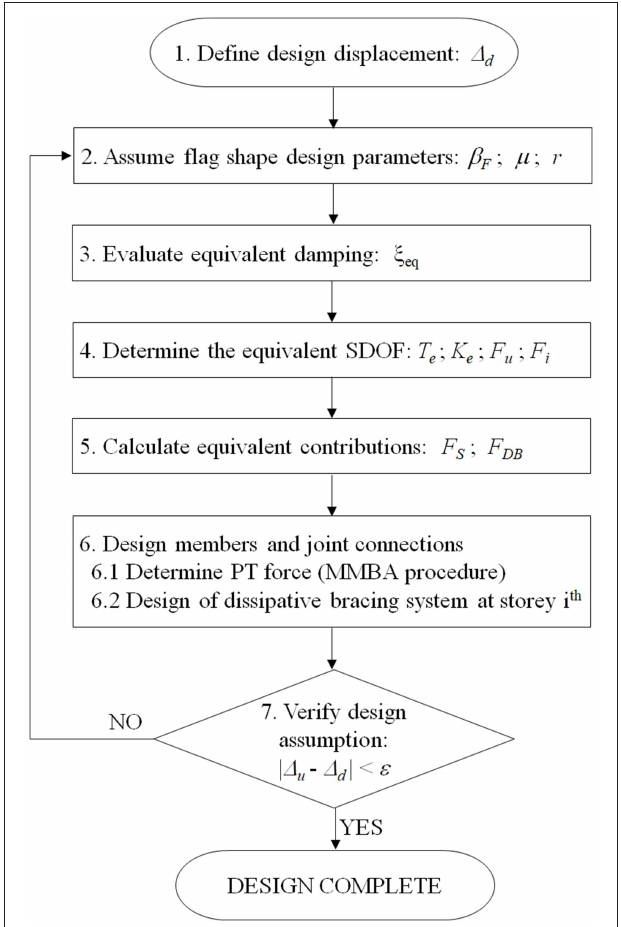
FIGURE 2 | Design procedure.